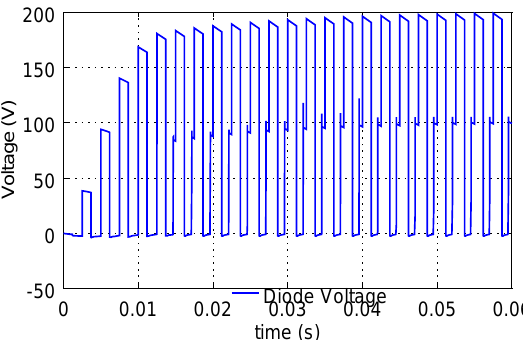
Figure 7: The voltage between the diode terminals